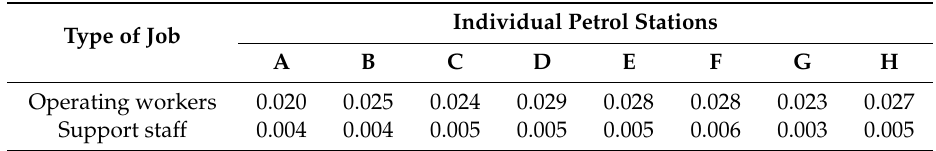
Table 5. Calculated HQ at LADD (mg/kg/day) for inhalation exposure to MTBE in petrol stations. Type of